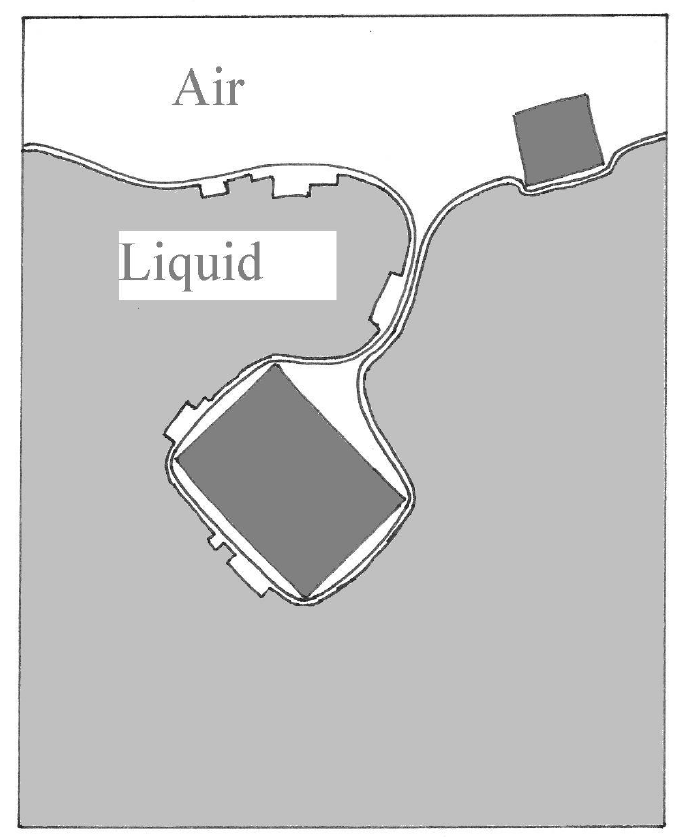
Figure 3. The entrainment of the surface oxide as an extrinsic inclusion penetrates the surface of a